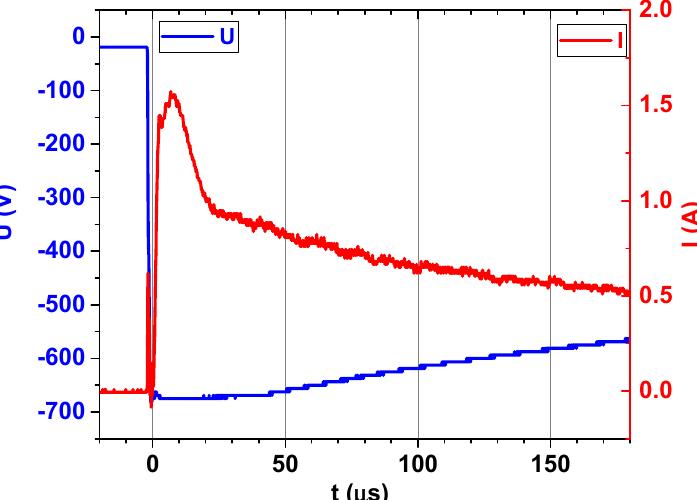
Figure 1. Typical HiPIMS voltage and current pulse shapes used for the deposition of Ag under HiPIMS conditions.